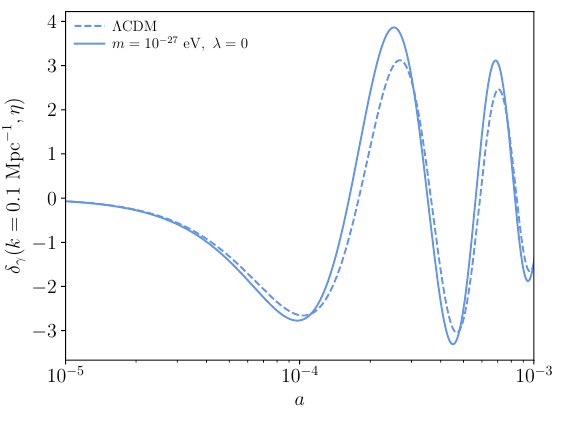
Figure 5 . Sound speed at decoupling for photons and dark matter. Around k sound speed for both (cid:13)uids, hence the oscillation frequency too, are close and we have a resonant driving.